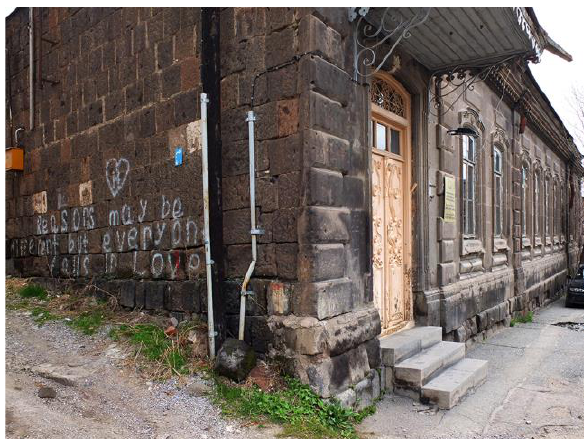
Figure 4. Above, the Cathedral of Ani (built in 989–1001); below, the St. Savior Church in Alexandropol.